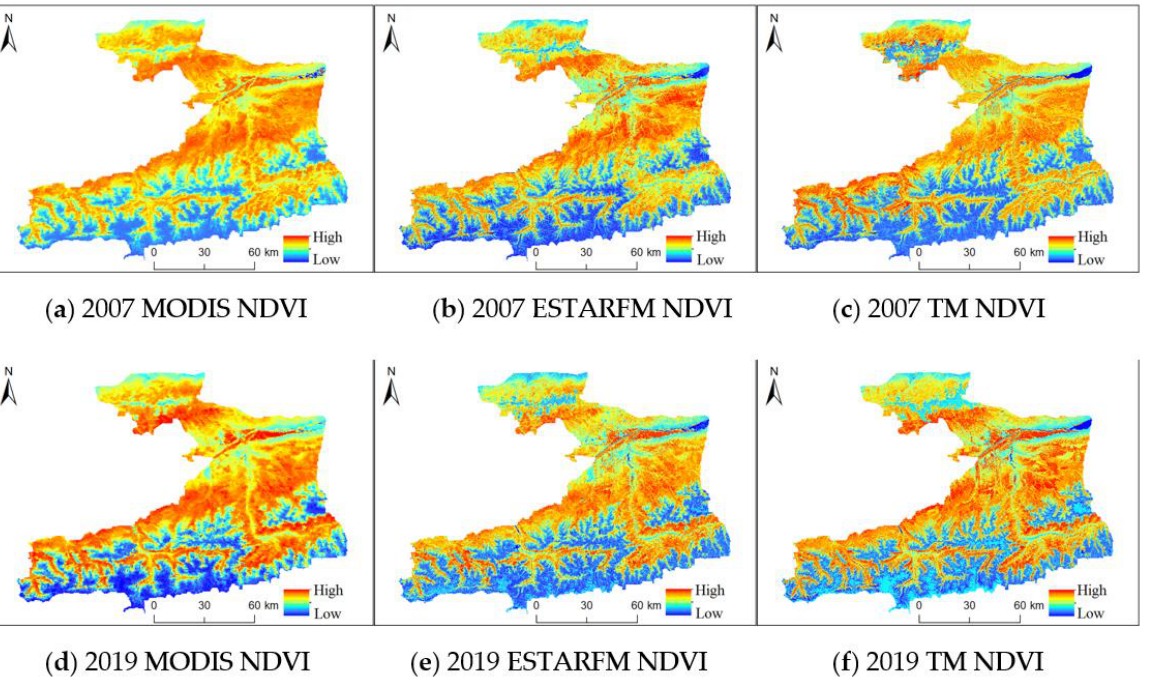
Figure 2. Comparison of ESTARFM model fusion results.